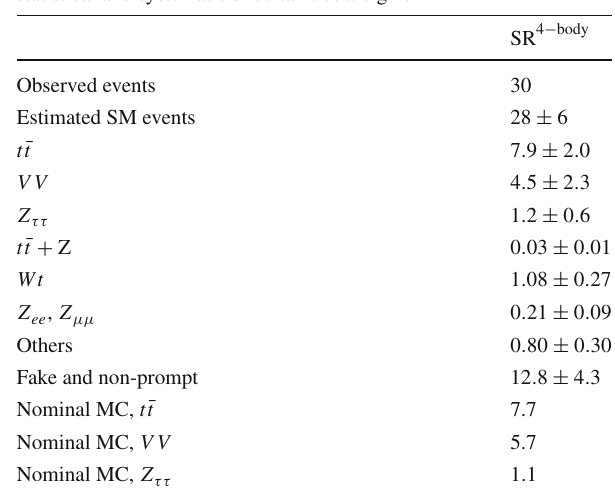
Table 18 Four-body selection background fit results for SR 4 nominal predictions from MC simulation, are given for comparison for those backgrounds ( t ¯ t , VV and Z ττ ) that are normalised to data in dedicated CRs. The “Others” category contains the contributions from t ¯ tW , t ¯ th , t ¯ tWW , t ¯ tt , t ¯ tt ¯ t , Wh , ggh and Zh production. Combined statistical and systematic uncertainties are given